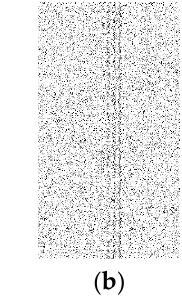
Figure 5. ( a ) is the completely random cases; ( b ) is from a weak technique.